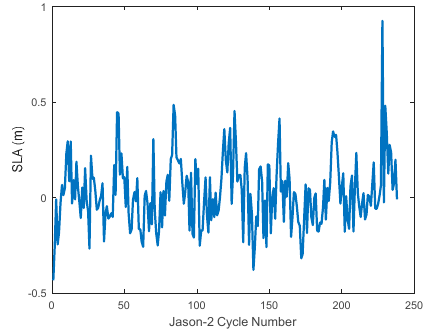
Figure 4. HK tide gauge sea level time series (in meters) interpolated to Jason-2 observations.